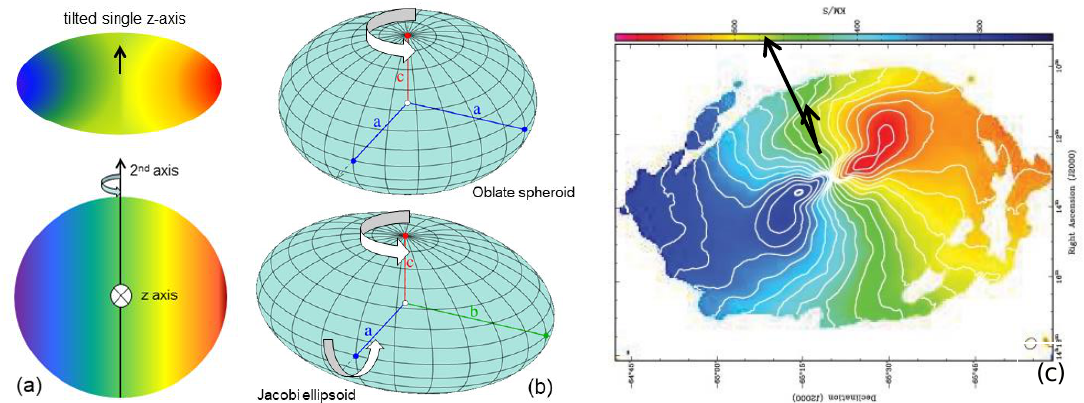
Figure 6. Indication of multiple spin axes: ( a ) Schematics of a single rotation of a tilted spiral (top) and a simple secondary rotation for a face-on spiral; ( b ) Wire diagrams of the oblate spheroid and Jacobi’s triaxial ellipsoid, with spinning about the short axes added to images created by Ag2gaeh and publicly available at https://en.wikipedia.org/wiki/Ellipsoid#/media/File:Ellipsoide.svg under a Creative Commons Attribution Share Alike 4.0 International license; ( c ) The mean velocity field of Circinus, showing superimposed spins around two axis (black arrows), which are nearly parallel as presented to the LOS, modified after figure 13b in “The Local Volume HI Survey (LVHIS)” by B.S. Koribalski et al. (2018) Mon. Not. R. Astron. Soc. 478 , 1611–1648 [56].